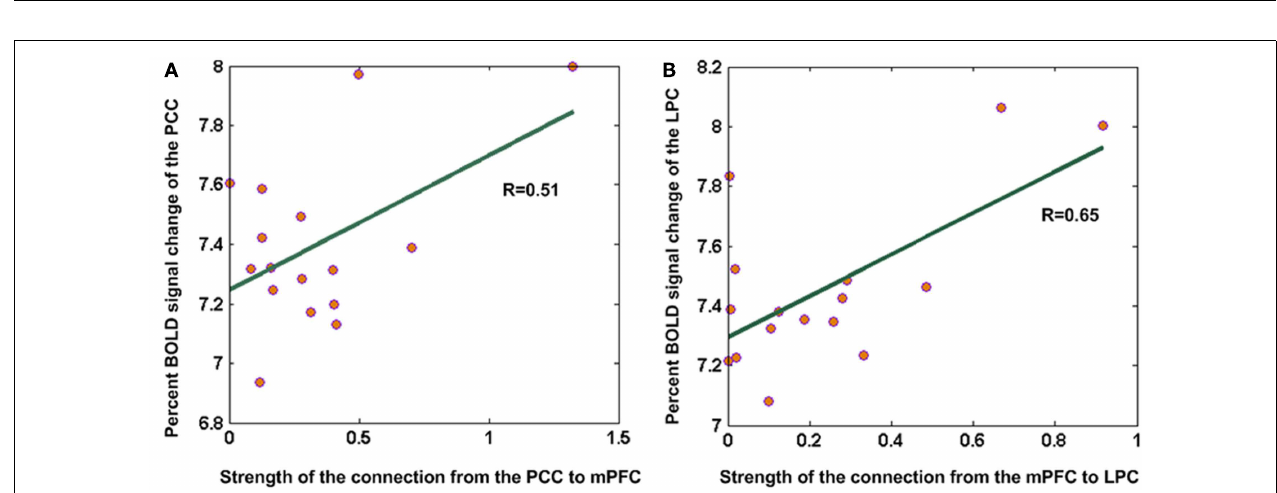
its effective connection to the mPFC. (B) Percent BOLD signal change in the LPC was significantly ( p = 0.006) correlated with the strength of the effective connection from mPFC to